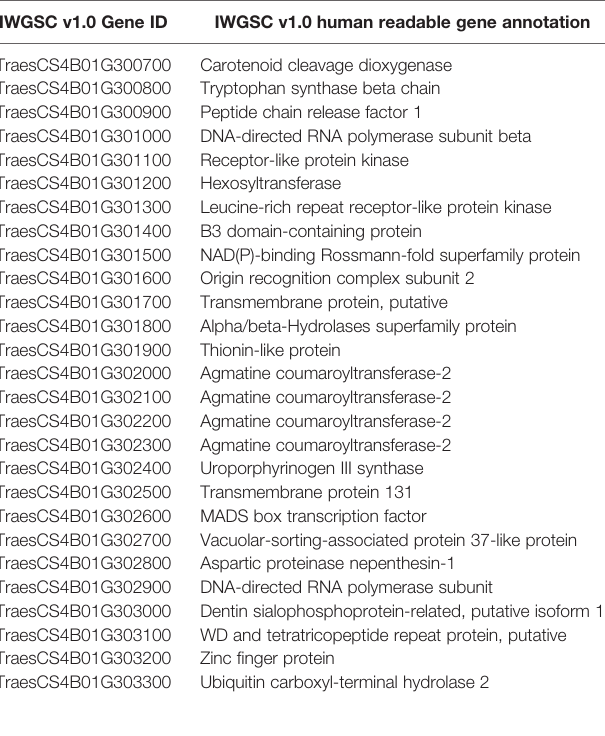
TABLE 3 | High con fi dence genes annotated in the IWGSC v1.0 genome sequence between fl anking markers sunKASP_21 and markers cosegregating with sunKASP_24 .